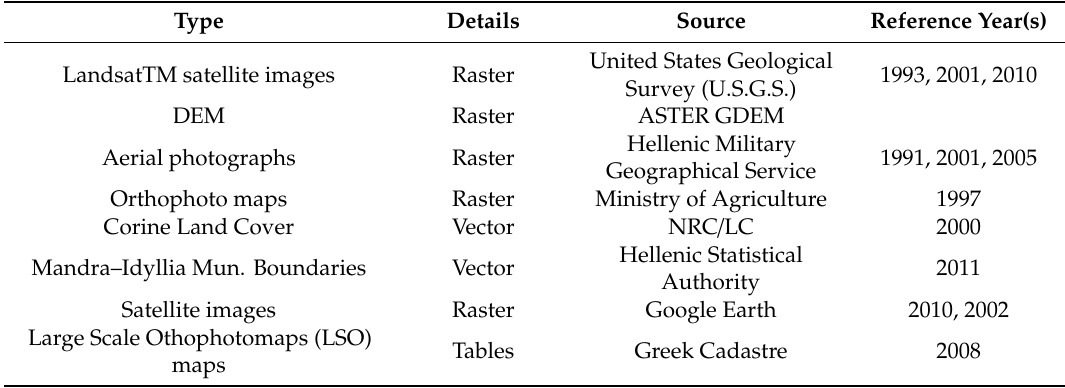
Table 1. The used data of this